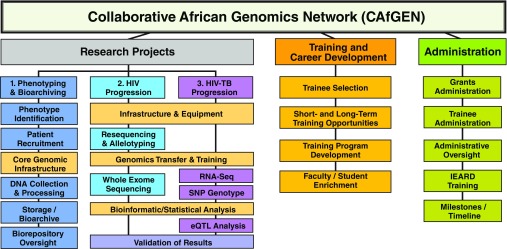

CAfGEN Activities.